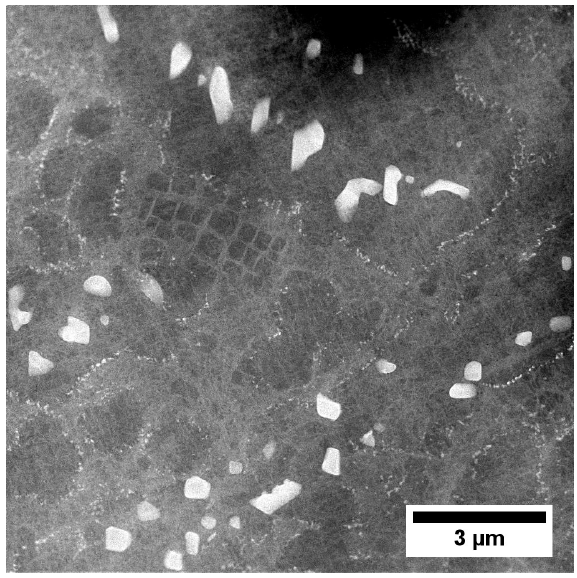
Figure 16. Microstructure of precipitates in the interdenritic spaces, STEM-HAADF.